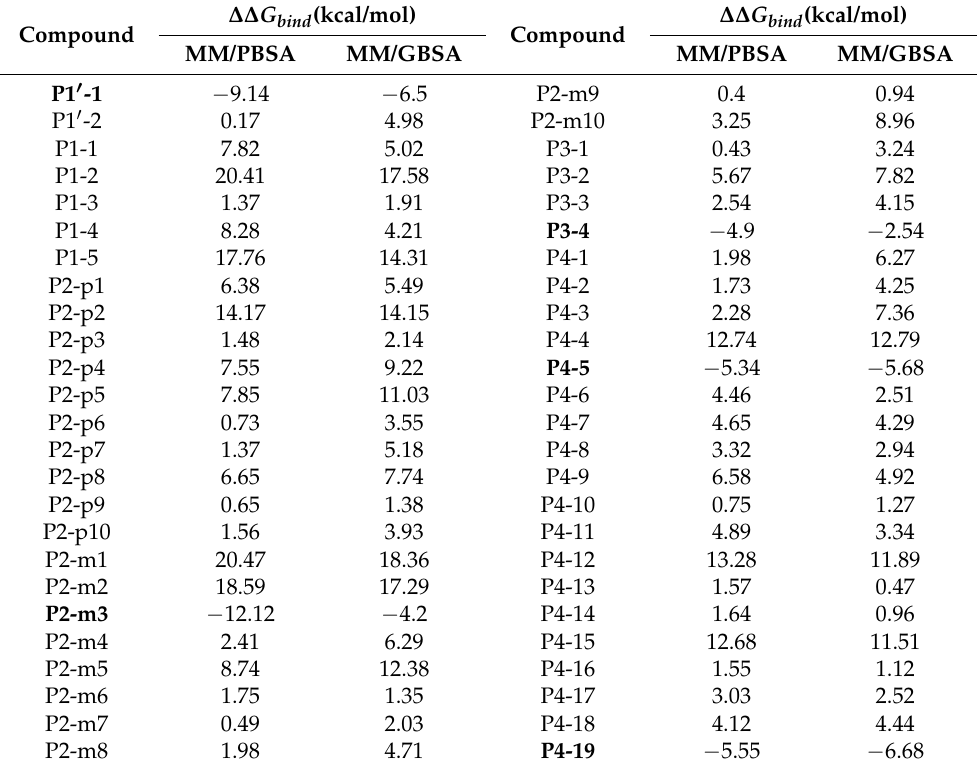
Table 1. Relative interaction energy ( ∆∆ G bind ) of the designed compounds in comparison to rupin- trivir against EV-A71 3Cpro derived from MM/PBSA and MM/GBSA methods ( ∆ G rupintrivir of bind − 19.38 and − 32.83 kcal/mol, respectively). The compounds with negative ∆∆ G bind are in bold, and their 2D structures are given in Figure 2. ∆∆ G ∆∆ G bind (kcal/mol) bind Compound Compound